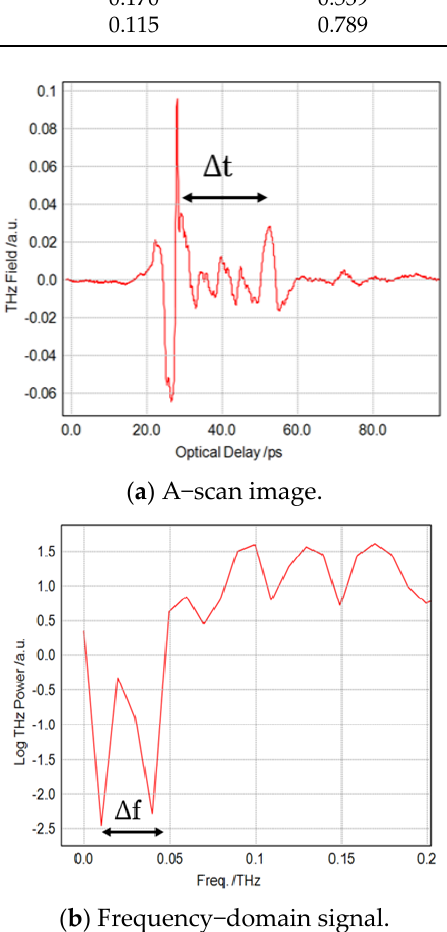
Figure 8. A TOF and FFT image of the GFRP composites under the reflection mode (2.02 mm in thickness). Table 3. Measurements of the GFRP composites with various thicknesses using the THz techniques. Delay Time ( ∆ t Sample No.